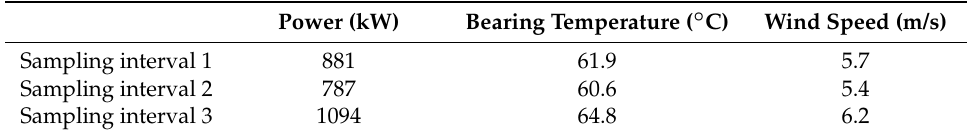
Table 6. Average power, bearing temperature, and wind speed during the first three sampling